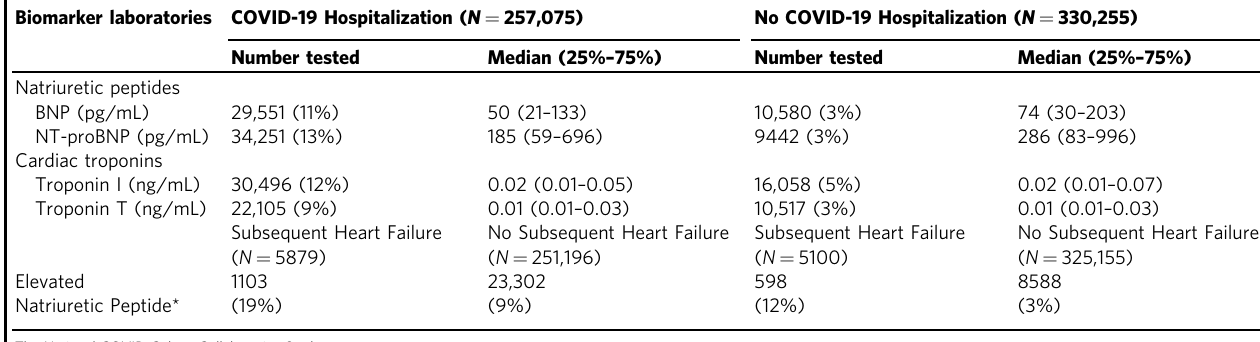
The National COVID Cohort Collaborative Study. BNP B-type natriuretic peptide, NT-proBNP N-terminal prohormone brain natriuretic peptide. *Natriuretic peptides considered elevated if BNP>100pg/mL or NT-proBNP >300pg/mL.